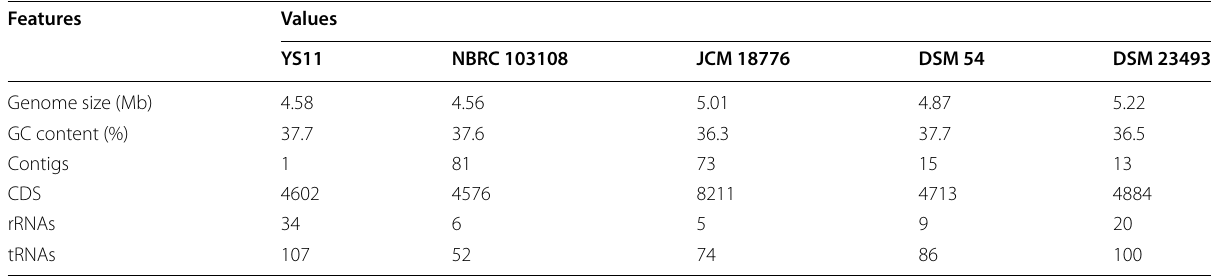
Table 1 Genomic features of L. boronitolerans YS11 compared with other Lysinibacillus species including L. boronitolerans